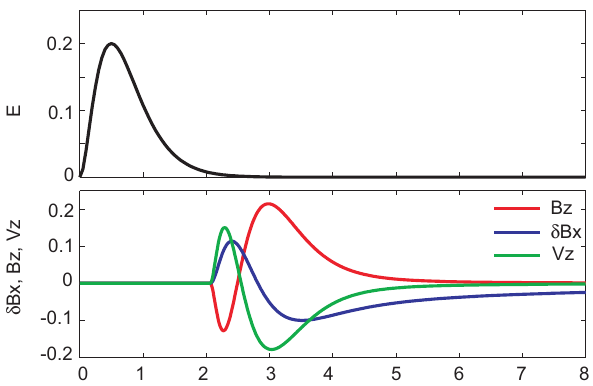
Fig. 29. Variations of the reconnection rate (top) and the corre- sponding disturbances of δB x = B x − B 0 ,B z and v z observed by an artificial spacecraft at the point x = 1 ,z = . 5 in the inflow region (bot- tom). Magnetic field is normalized to B 0 , velocity to Alfv´en veloc- ity v A , time to the duration of the pulse t 0 , and distance to v A t 0